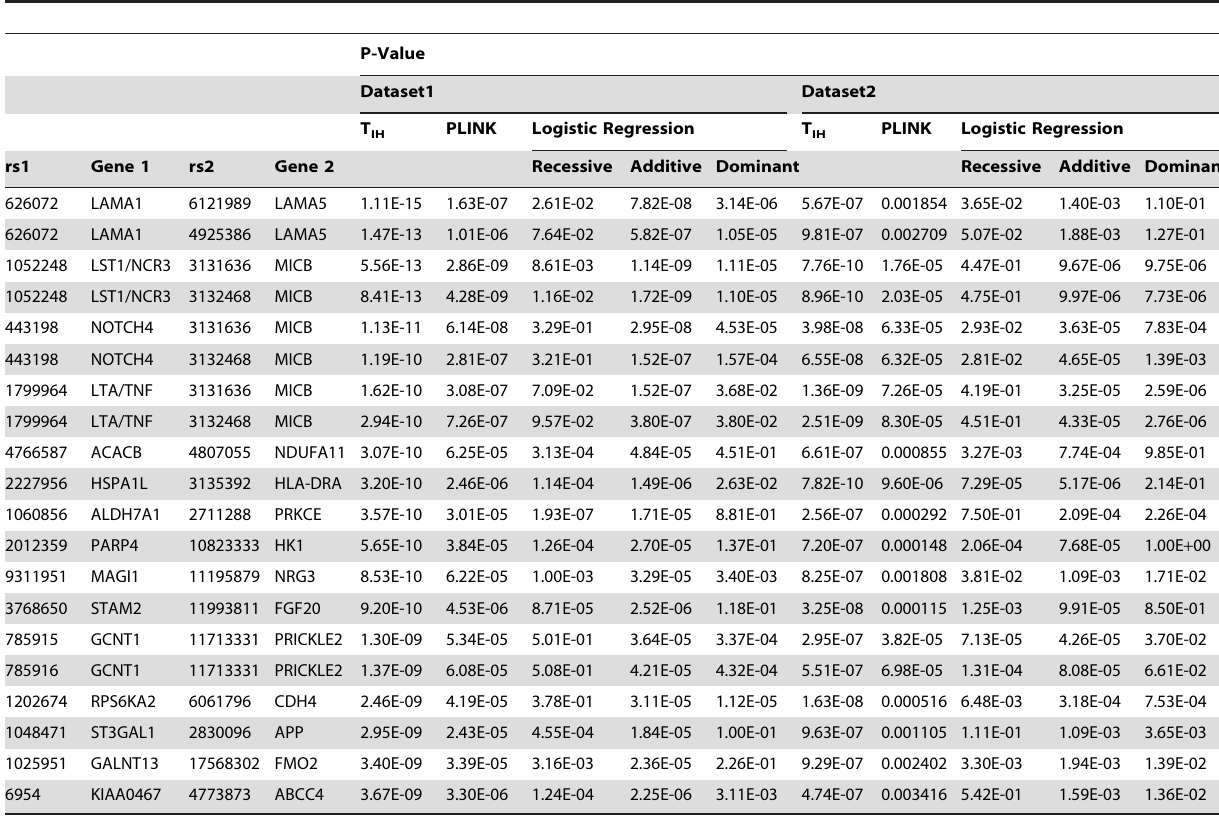
Table 7. P-values of 20 pairs of interacting SNPs calculated by the statistic TIH, PLINK, and logistic regression coded by genotypes.